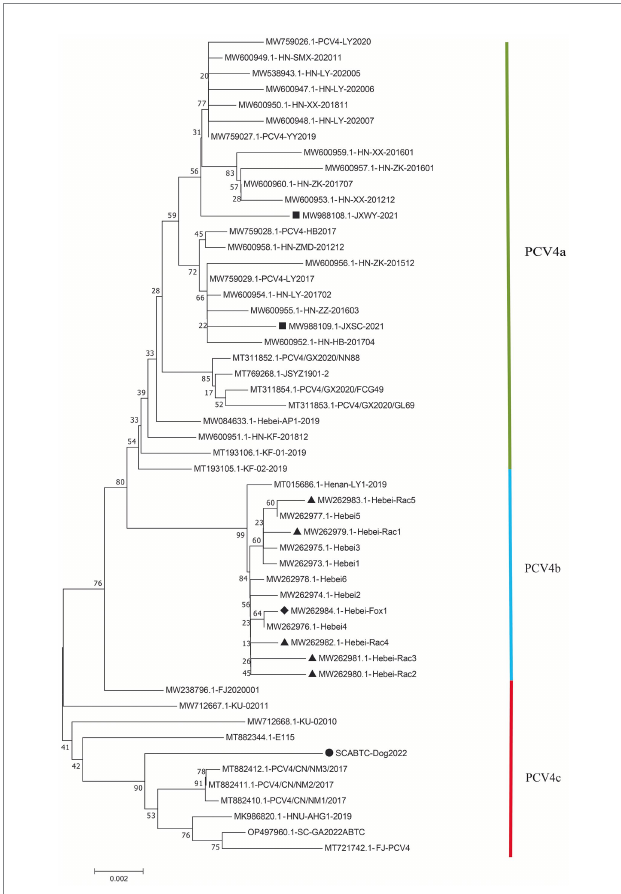
FIGURE 2 Neighbor-joining trees were constructed with a p-distance model and bootstrapping at 1,000 replicates. Phylogenetic tree was constructed based on the complete genome of 52 PCV4 strains. The black solid triangle ( ▲ ) represented the PCV4 strains derived from raccoon dogs. The solid black diamond ( ◆ ) represented the fox-derived PCV4 strains. The solid black square ( ■ ) represents the PCV4 strains originating from wild boars. The black solid circle ( ● ) represented the dog-derived PCV4 strain (SCABTC-Dog2022) in this study. All unlabeled strains were from domestic pigs. The subtypes were proposed by Xu et al.